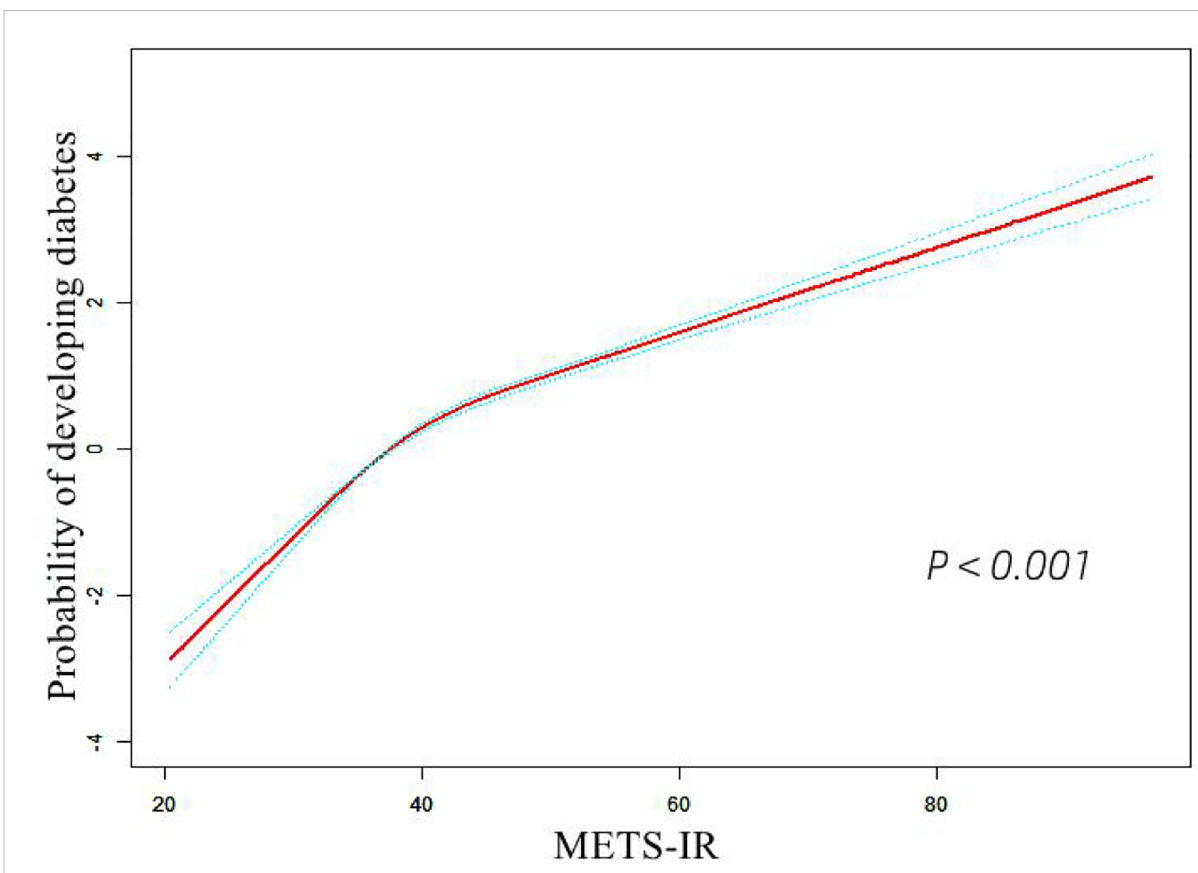
FIGURE 2 The non-linear relationship between METS-IR and incident of diabetes. Abbreviation: METS-IR: the metabolic score for insulin resistance.